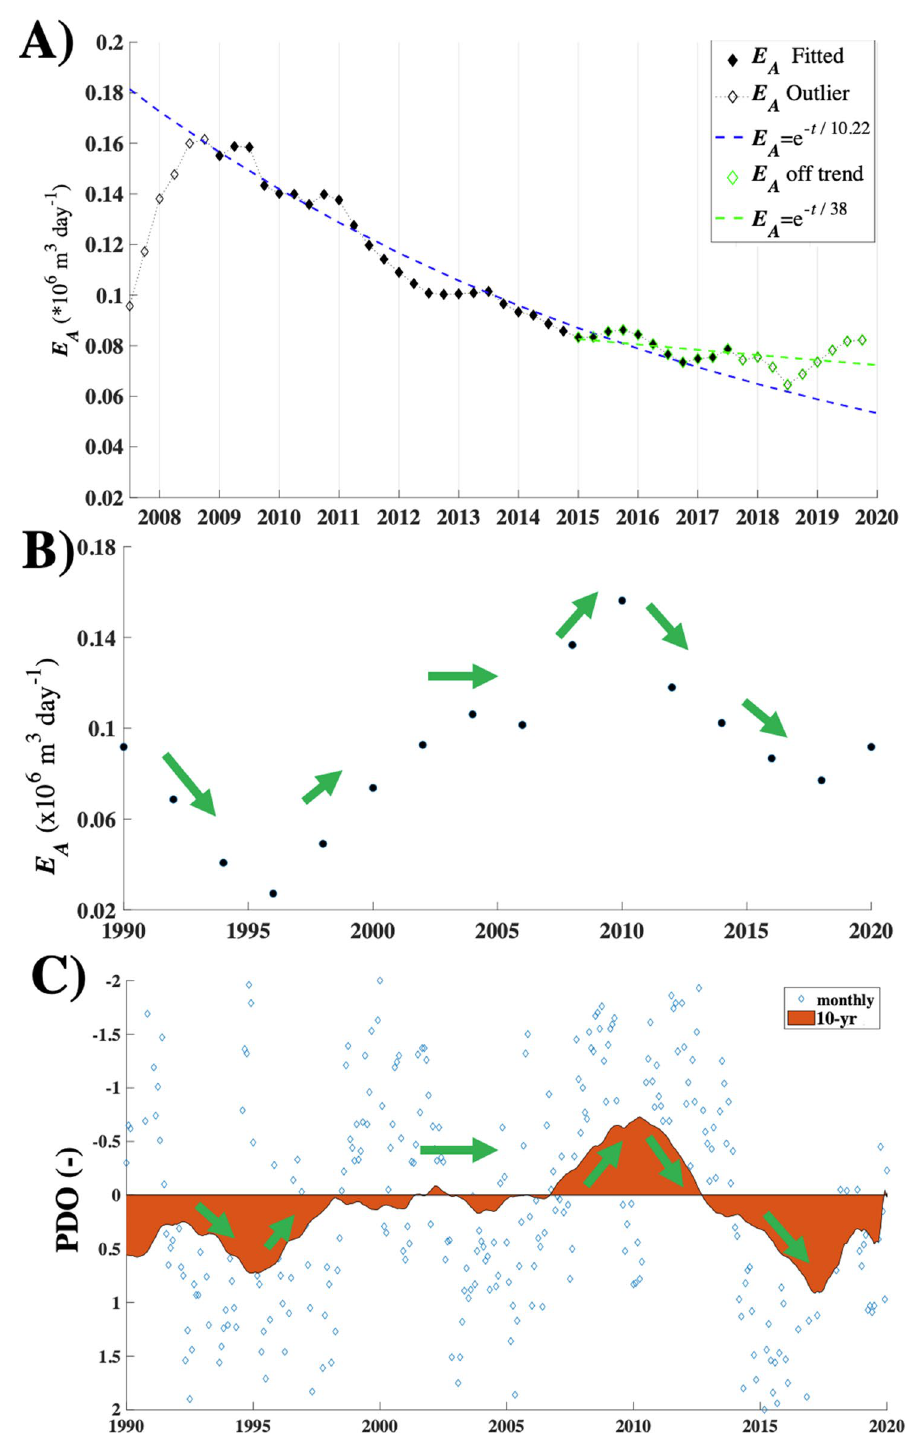
Figure 8. ( A ) COP seep field atmospheric emissions, E A , annual simulation, and least-squares linear-regression analysis exponential curve fit. ( B ) E A for the Cycle simulations. See Supplementary Fig. S7–S8 for maps of E A for the Cycle and Annual simulations, see text for details. ( C ) Pacific Decadal Oscillation (PDO) monthly and 10-year smoothed. Green arrows illustrate trend directions. PDO from ERDDAP 32